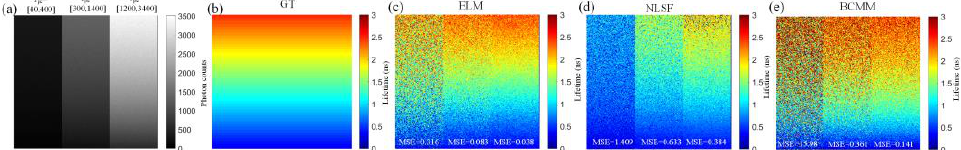
Figure 5. ( a ) Intensity image of GT τ A in exact ranges. I pc depicts total photon counts in one pixel. The range from 40 to 400 is viewed as low photon counts. ( b ) the GT τ A lifetime image with the range ~ [0.3, 2.5] ns. ( c – e ) reconstructed τ A images from ELM, NLSF, and BCMM. Table 1. Time Consumption (Seconds) of NLSF And ELM for Inference Lifetime Parameters.